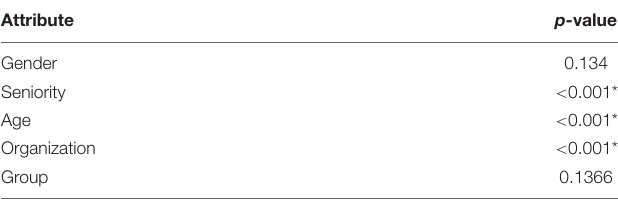
TABLE 4 | Exponential random graph model (ERGM) results for attribute-based mixing for individual stakeholders ( n = 35) forming the egocentric PHBSC fishery